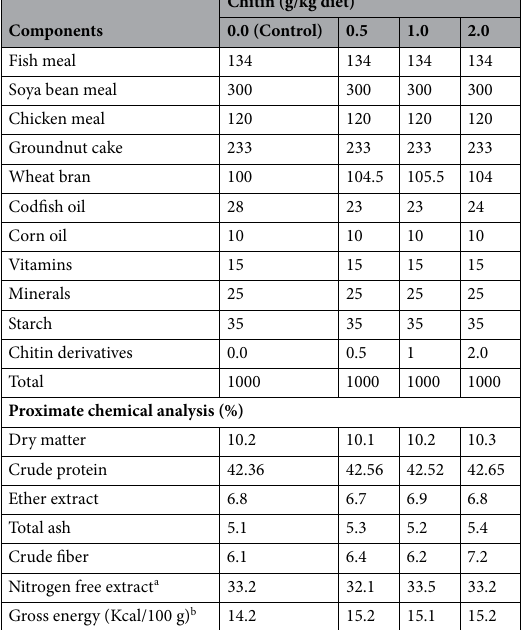
As indicated in Table 1, five dietary supplements including 0.0 (control), 0.5%, 1% , and 2% chitin degrada- tion product feed were developed to give optimal 42% (w/w) crude protein. In addition, different quantities of the chitin derivatives feed supplement was mixed in 100 mL/kg feed and homogenized for 30 min with the other components to make fine consistency dough (Table 1). The dough was mixed in a mixer at the same time and pelleted using a paste extruder with a diameter of around 1 mm. The feed pellets were dried for 24 h at 55 °C and stored at − 20 °C for future use. Experimental design. Four rectangular fiberglass tanks (100 L) were placed with continuous aeration.